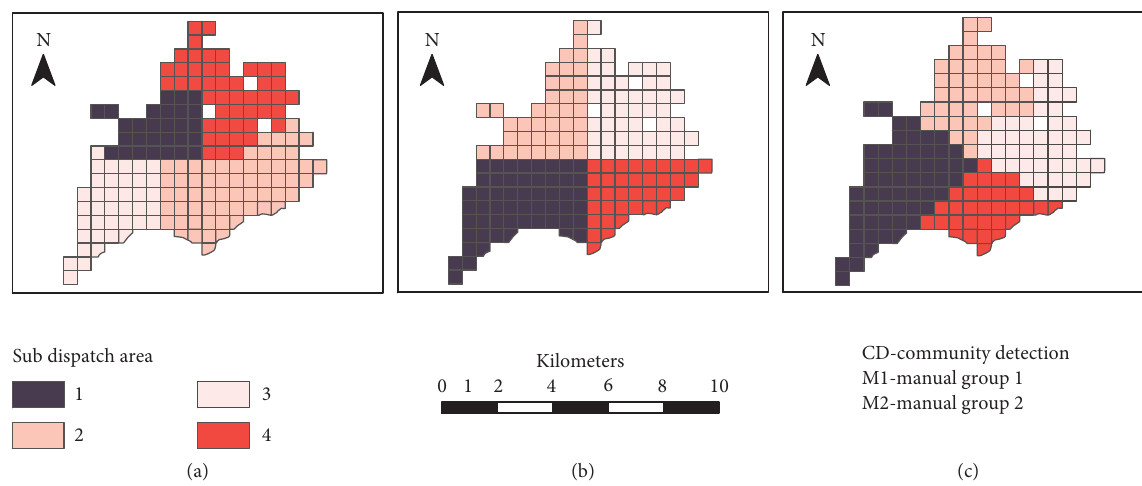
Figure 10: Three division groups of the dispatch area in Luohu District at morning peak. Table 7: The scheduling cost of different division groups of the dispatch area in Luohu District. Dispatch